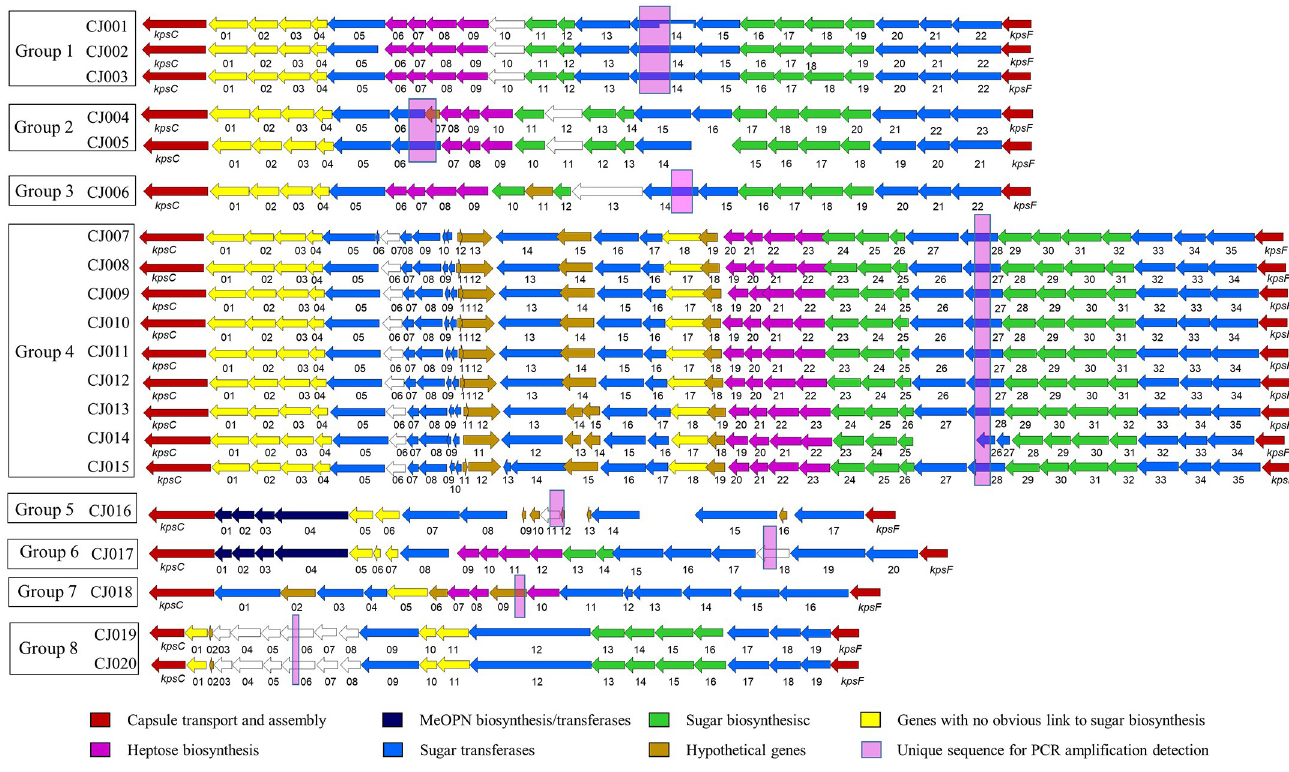
Fig 1. Schematic diagram of variable CPS loci of untypeable Campylobacter jejuni (CJ001 to CJ020) sequences. Genes are color coded as shown in the figure on the basis of best homology to any predicted proteins in databases by http://rast.nmpdr.org.